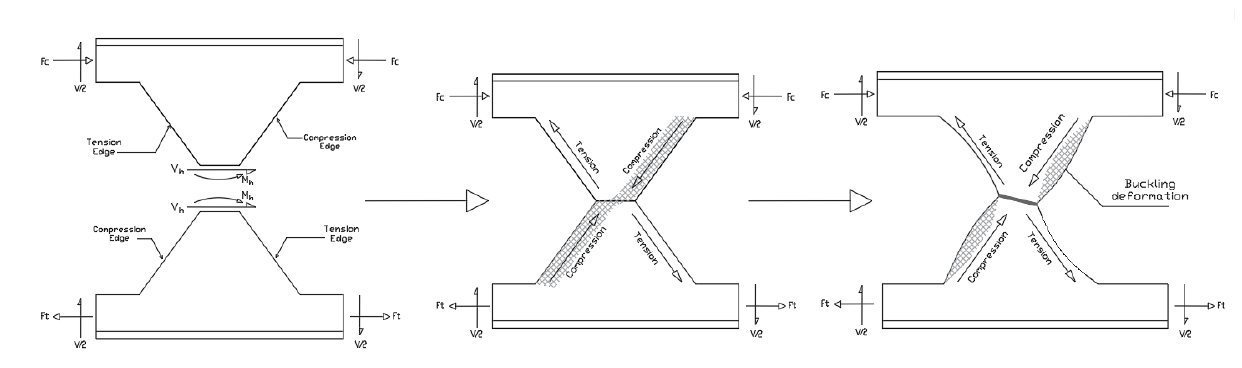
Figure 15: Web-post buckling due to shear force